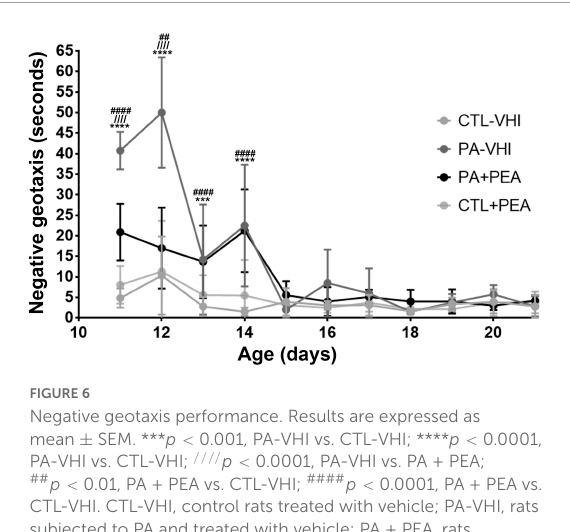
FIGURE6 Negative geotaxis performance. Results are expressed as mean ± SEM. *** p < 0.001, PA-VHI vs. CTL-VHI; **** p < 0.0001, PA-VHI vs. CTL-VHI; //// p < 0.0001, PA-VHI vs. PA + PEA; ## p < 0.01, PA + PEA vs. CTL-VHI; #### p < 0.0001, PA + PEA vs. CTL-VHI. CTL-VHI, control rats treated with vehicle; PA-VHI, rats subjected to PA and treated with vehicle; PA + PEA, rats subjected to PA and treated with PEA; CTL + PEA, control rats treated with